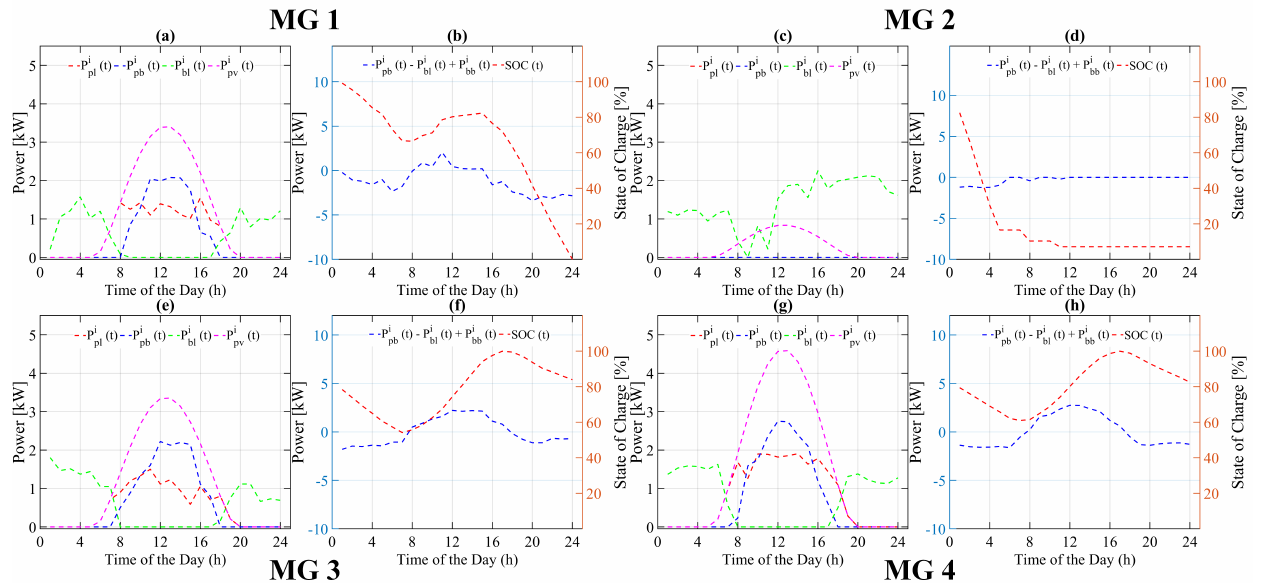
Figure 12. Power flow of various system variable of each microgrid using heuristic state flow based energy management strategy for case D. ( a , c , e , g ) Power flow of PV, battery and Load, ( b , d , f , h ) Battery charging/discharging and state of